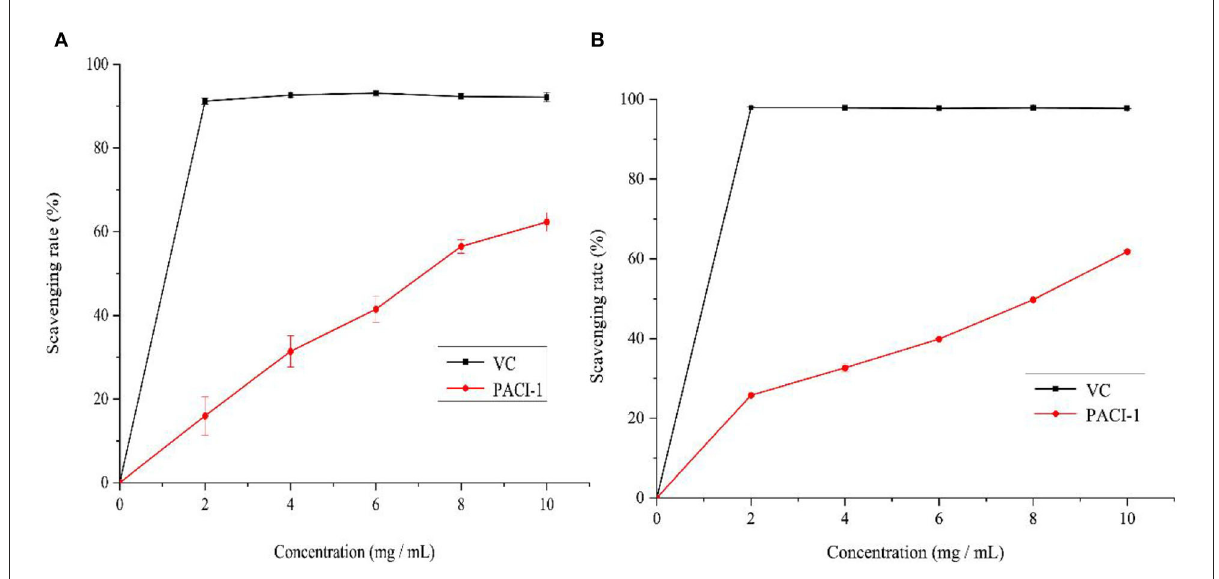
FIGURE7 Scavenging effect of PACI-1 on DPPH (A) and ABTS radicals (B)